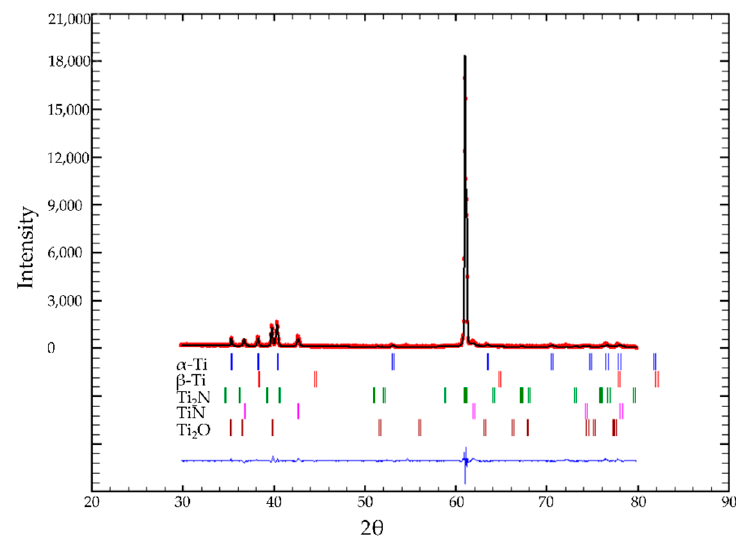
Figure 3. Schematic of the method of sample preparation for microstructural studies ( a ) and micro- hardness tests ( b ).